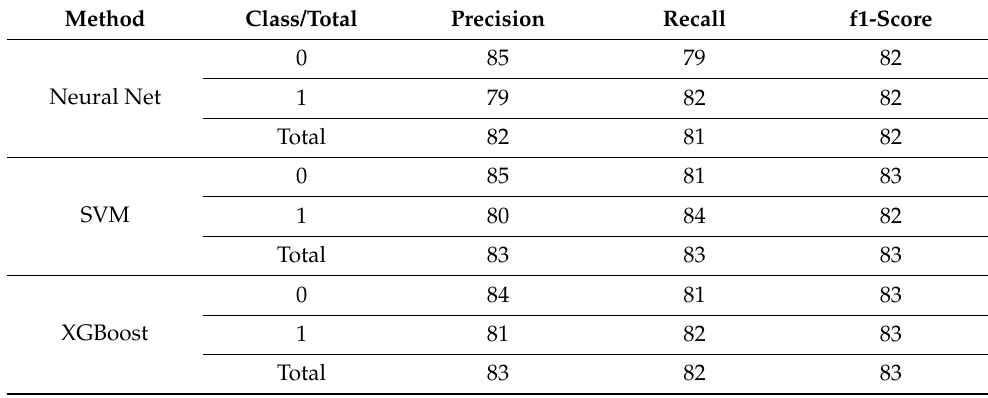
Table 2. Class and model